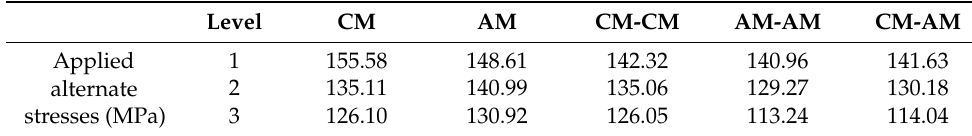
Table 6. Different stresses applied for the determination of the S-N